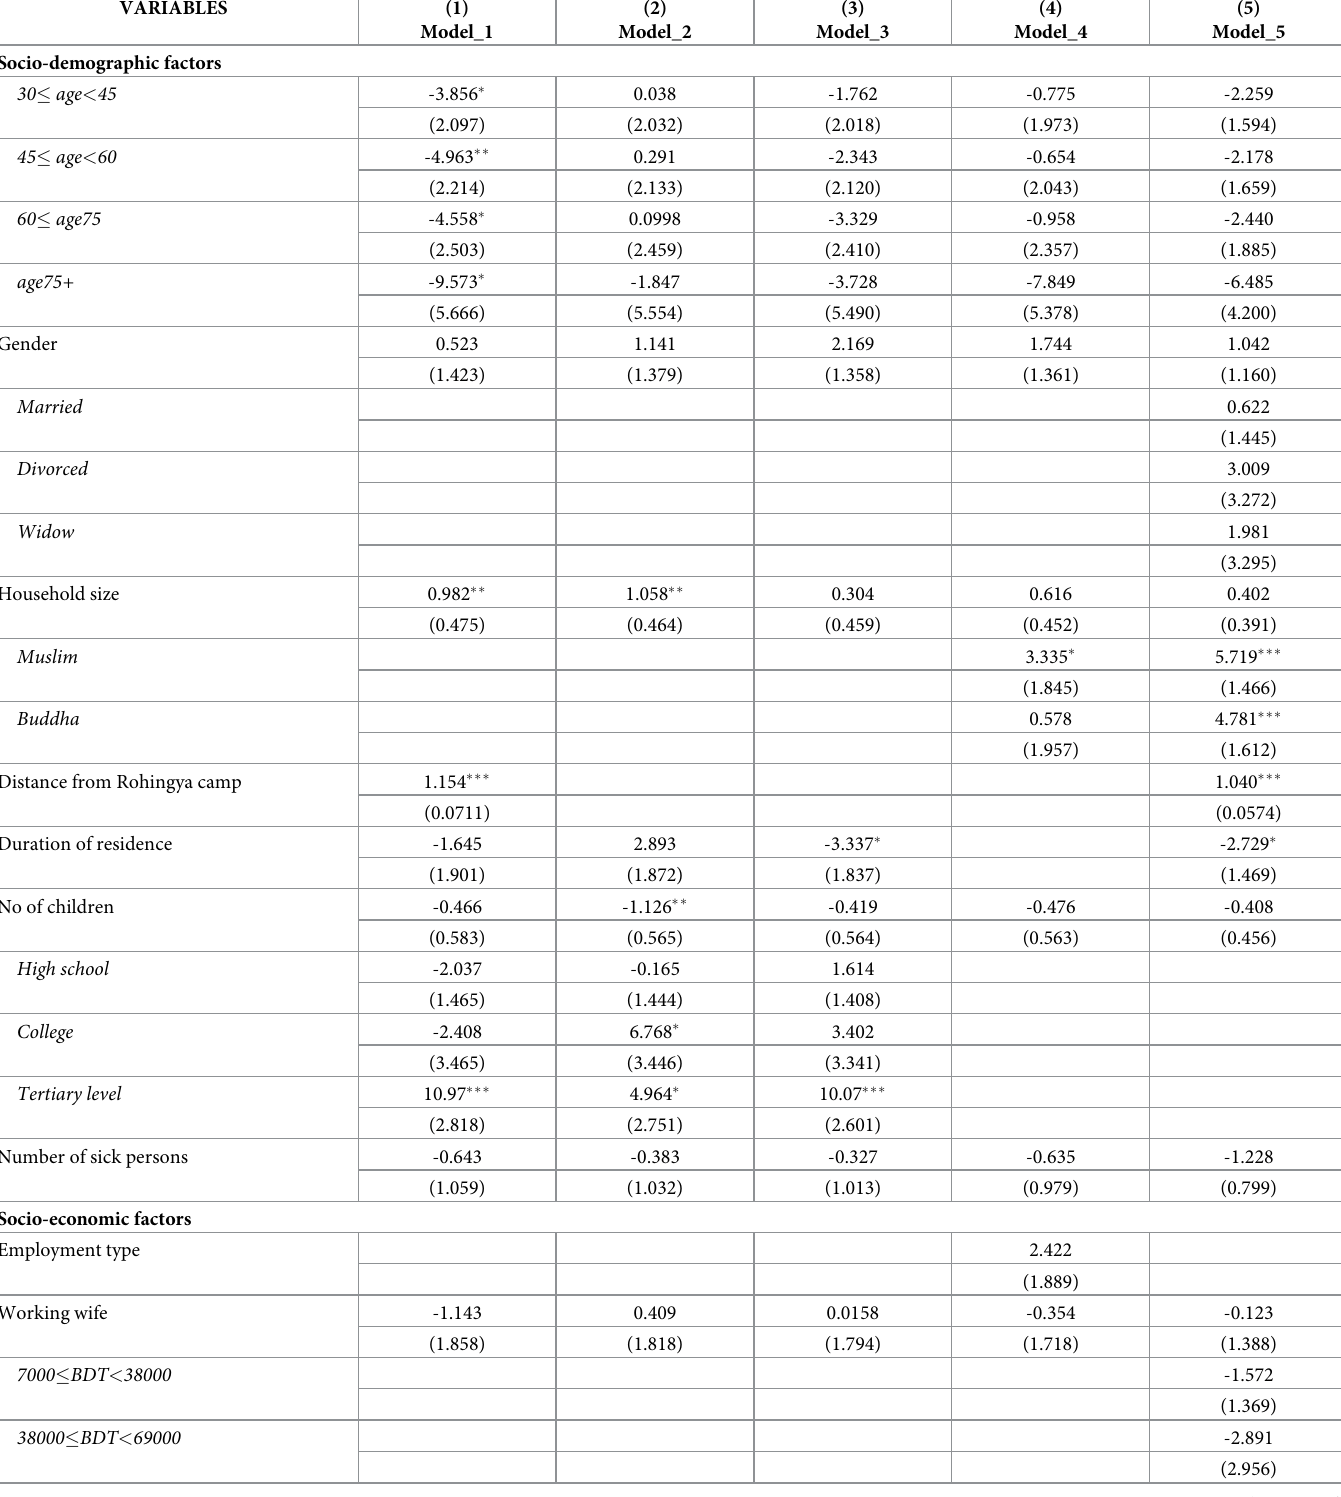
Table 6. Determinates of residential satisfaction (Index